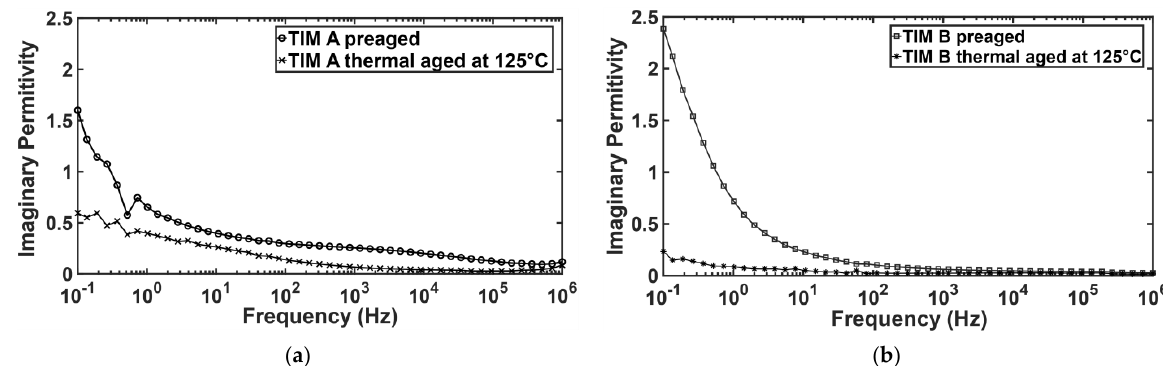
Figure 19. Imaginary permittivity of TIM A and TIM B.